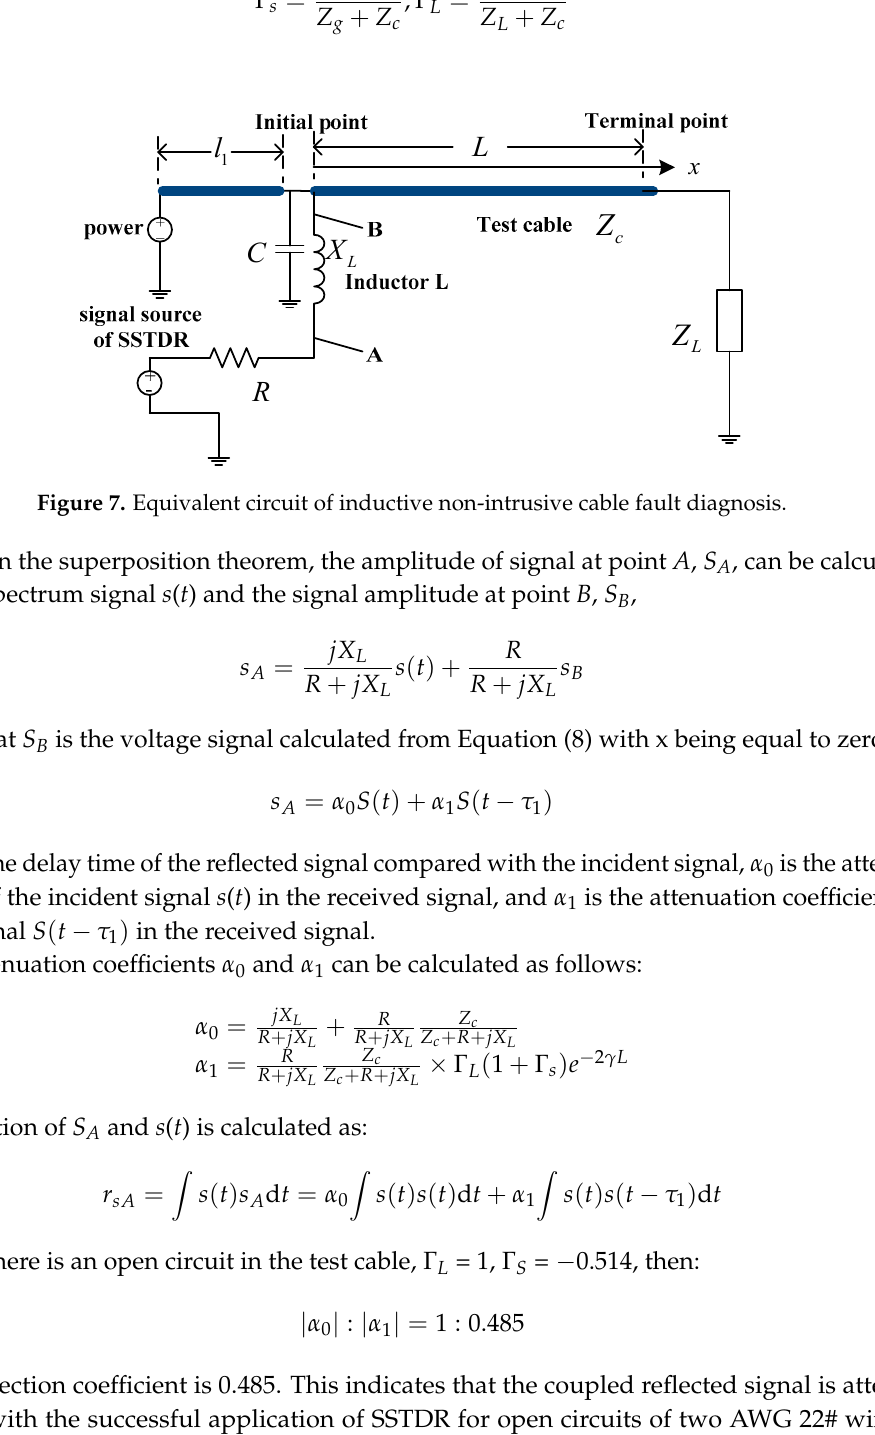
（ d ） Figure 6. Diagram of cable fault diagnosis with different values of capacitance. ( a ) The trapper with capacitance of 10 pF. ( b ) The trapper with capacitance of 100 pF. ( c ) The trapper with capacitance of 1 nF. ( d ) The trapper with capacitance of 10 nF.